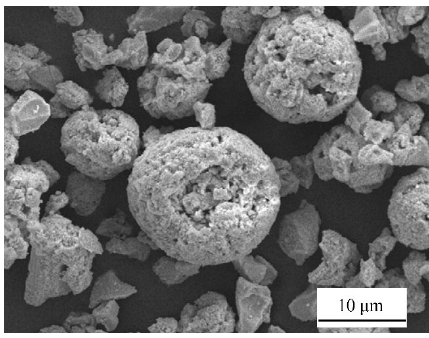
Fig. 70 Images of PS-PVD plasma jets expanding at different pressures: (a) 100 kPa (APS), (b) 15 kPa (LPPS), and (c) 150 Pa (PS-PVD). Reproduced with permission from Ref. [8], © The Nonferrous Metals Society of China and Springer-Verlag GmbH Germany, part of Springer Nature 2020.